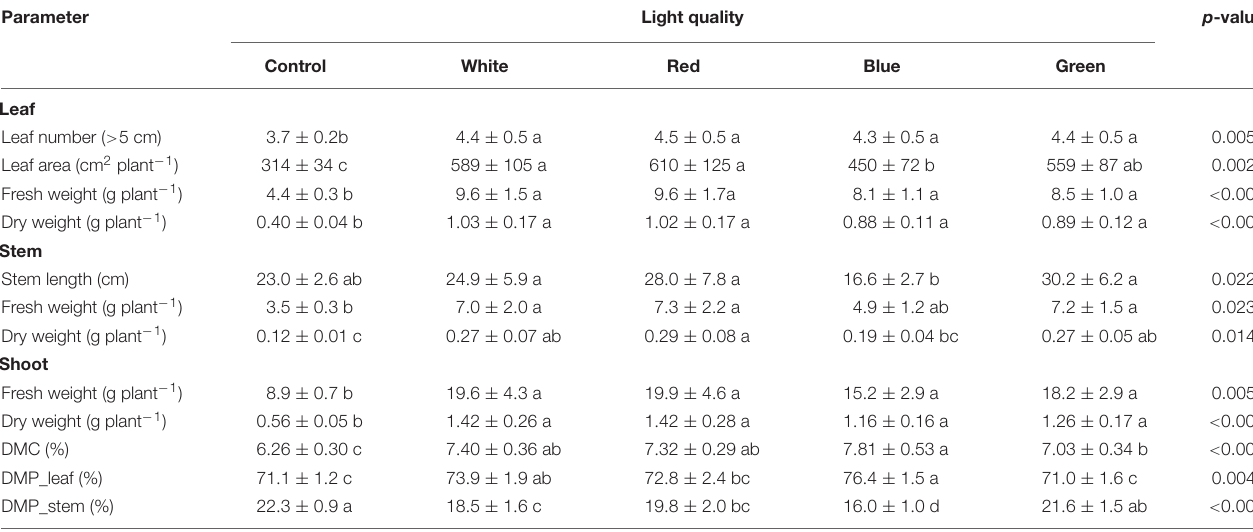
TABLE 5 | Growth and morphological traits of cucumber plants grown under different supplemental light